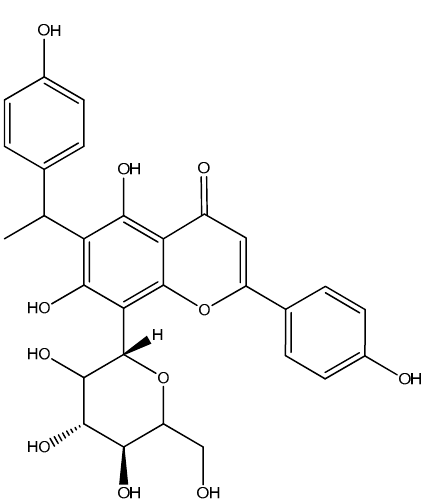
Figure 2. Tentative structure of 5,7,4 ′ -trihydroxy-6-(1-ethyl-4-hydroxyphenyl)flavone-8-C-glucoside (cucumerin A).